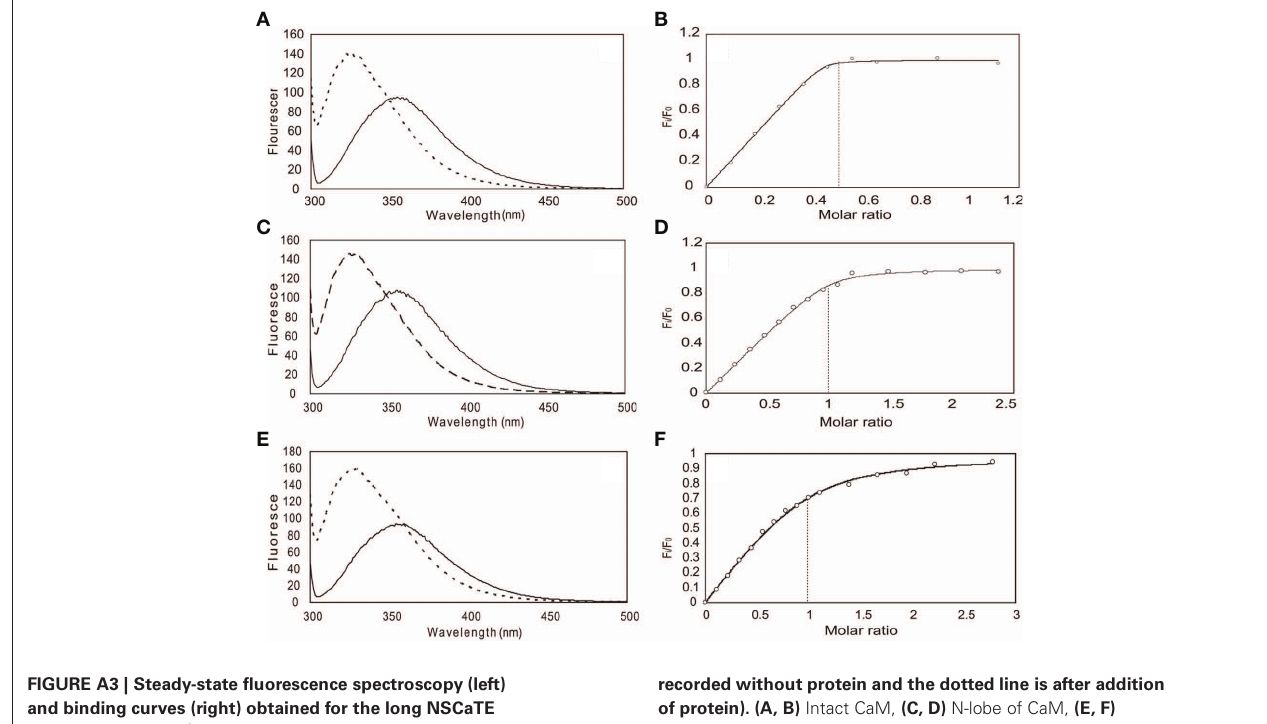
FIGURE A3 | Steady-state fluorescence spectroscopy (left) and binding curves (right) obtained for the long NSCaTE peptide with CaM. (In panels A, C and E, the solid line is